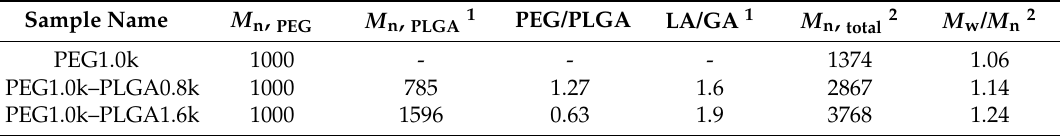
Table 1. Characteristics of PEG and PEG- b -PLGA diblock